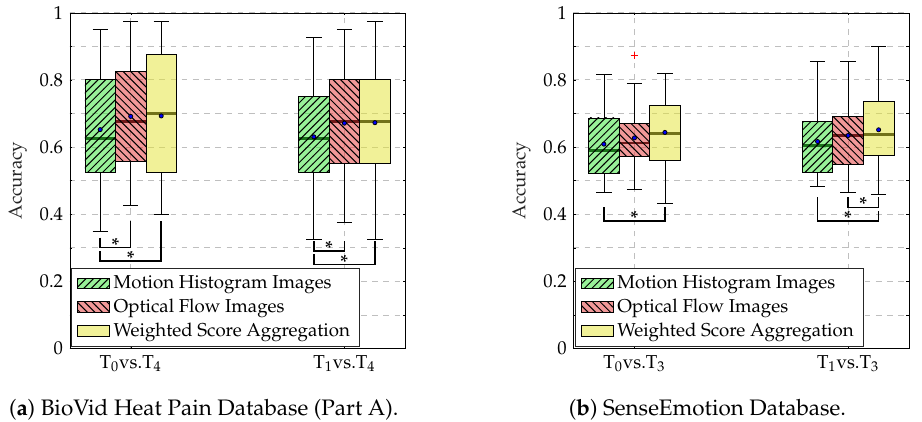
Figure 6. Classification performance (Accuracy). An asterisk (*) indicates a significant performance improvement. The test has been conducted using a Wilcoxon signed rank test with a significance level of 5%. Within each boxplot, the mean and the median classification accuracy are depicted respectively with a dot and a horizontal